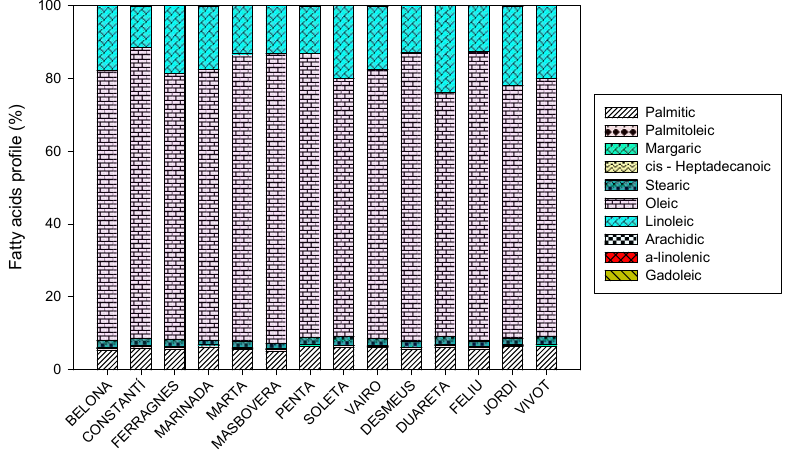
Figure 3. Fatty acids profile (expressed in % of total oil content) of each almond cultivar.